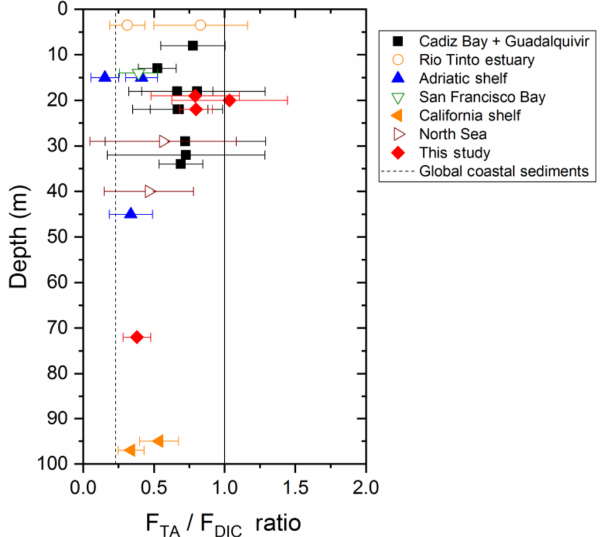
Figure 9. TA to DIC benthic flux ratios as a function of depth at stations A, Z and E of the Rhône River delta compared to different coastal regions of water depth < 100m, where this ratio was quan- tified from in situ benthic flux measurements (modified from Hu and Cai, 2011b). Other coastal regions include Cadiz Bay and the Guadalquivir continental shelf (Spain; Ferron et al., 2009), the Rio Tinto estuary (Spain; Ortega et al., 2008), the Po River delta and nearby Adriatic shelf (Italy; Hammond et al., 1999), San Francisco Bay (USA; Hammond et al., 1985), and the California shelf (USA; Berelson et al., 1996). The global coastal average TA to DIC flux ratio predicted from Krumins et al. (2013) is also reported for ref- erence. Note that this average is different from that reported by Hu and Cai (2011b), which was corrected in their later publication (Hu and Cai,